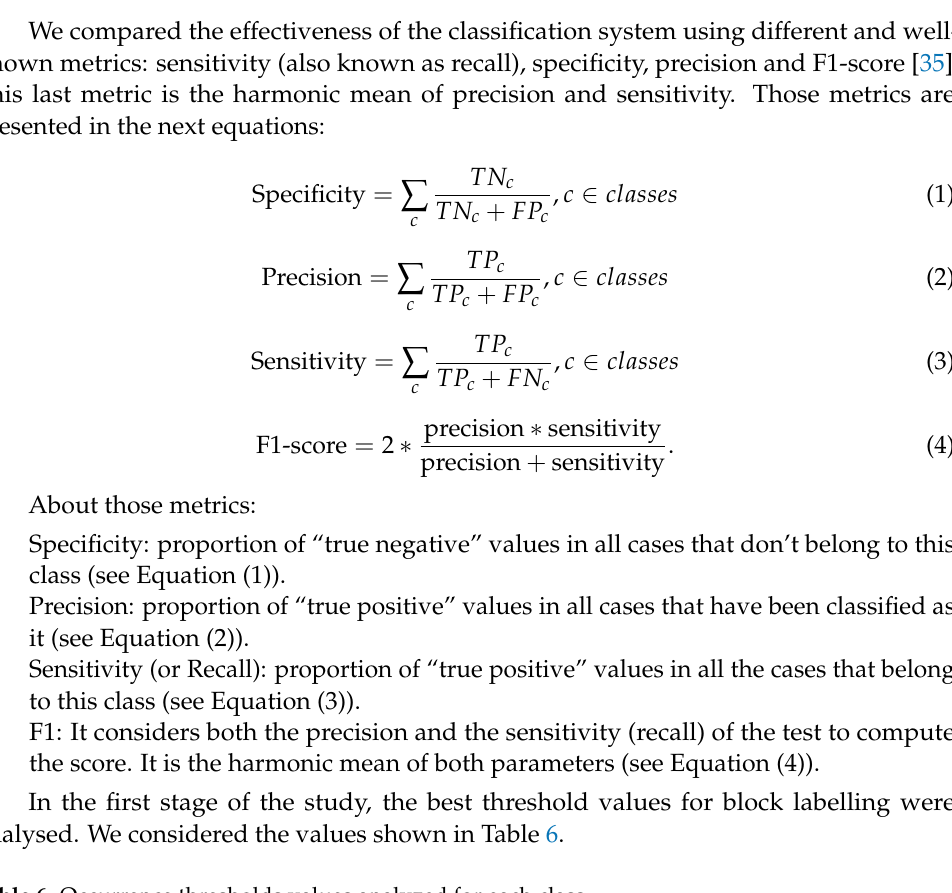
Table 6. Occurrence thresholds values analyzed for each